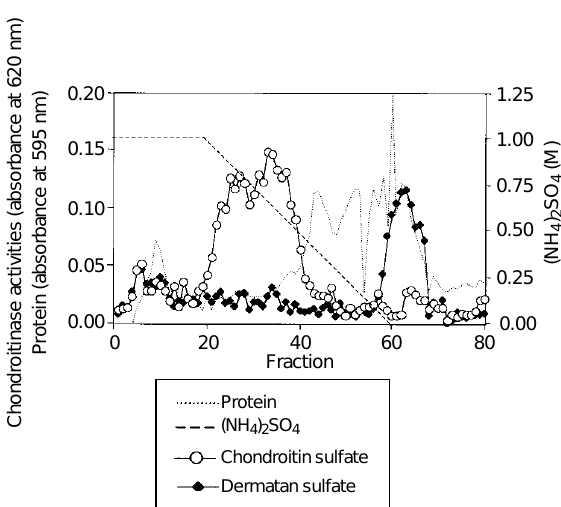
Flavobacterium heparinum chondroitinases AC and B